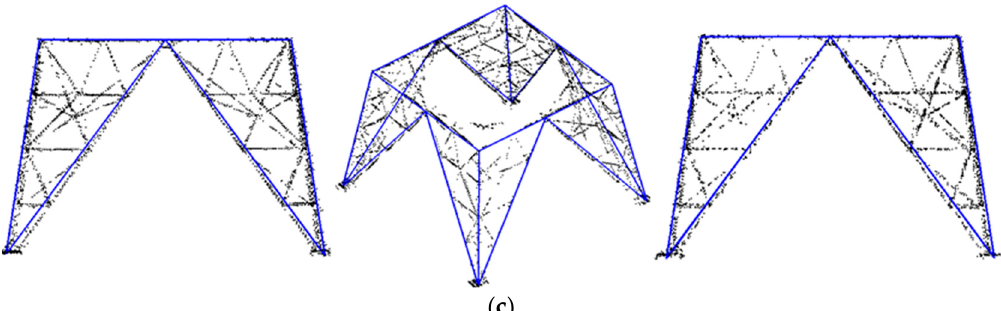
Figure 14. Four inverted triangular pyramids: ( a ) The model of four inverted triangular pyramids; ( b ) the plane division of four inverted triangular pyramids; ( c ) the reconstruction result.